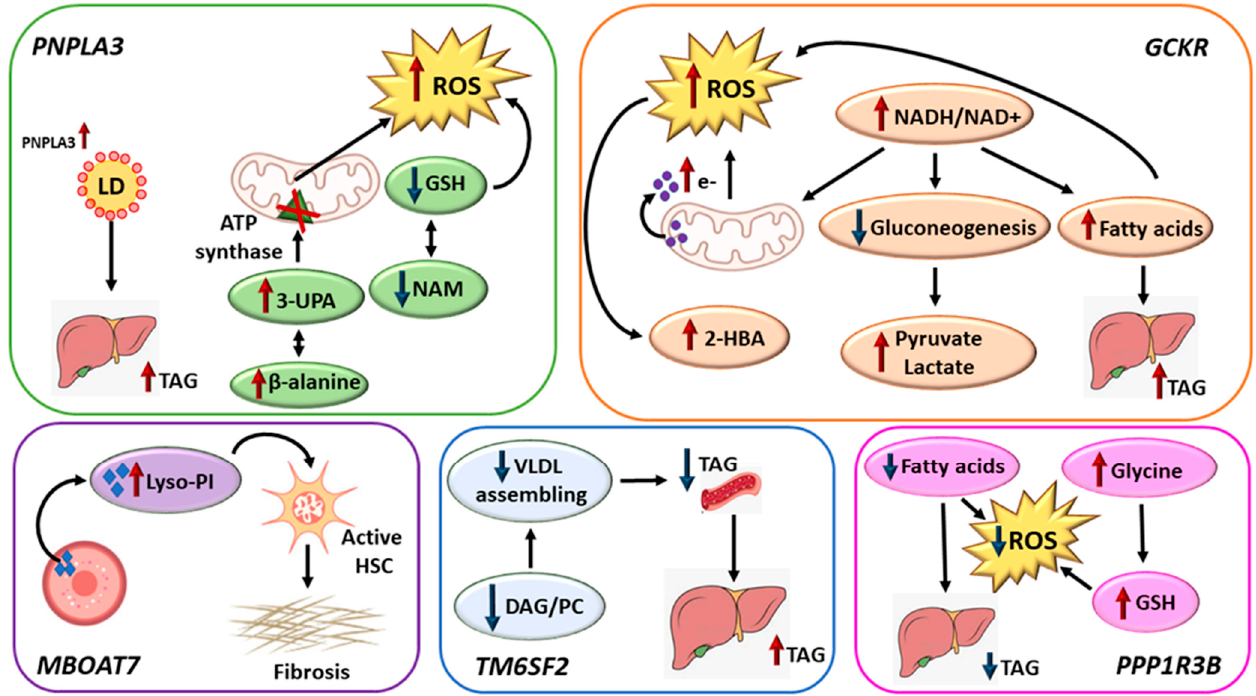
Figure 5. Summary of the main pathways of the five genetic variants associated with NAFLD.